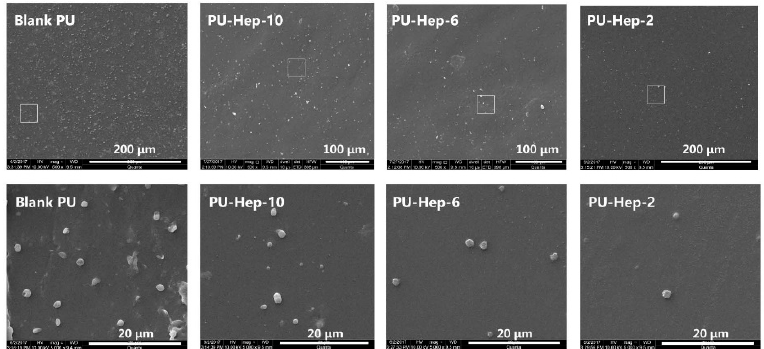
Figure 5. SEM images of platelet-rich plasma (PRP) morphology being contacted with PU and heparinized PU heparinized PU films.